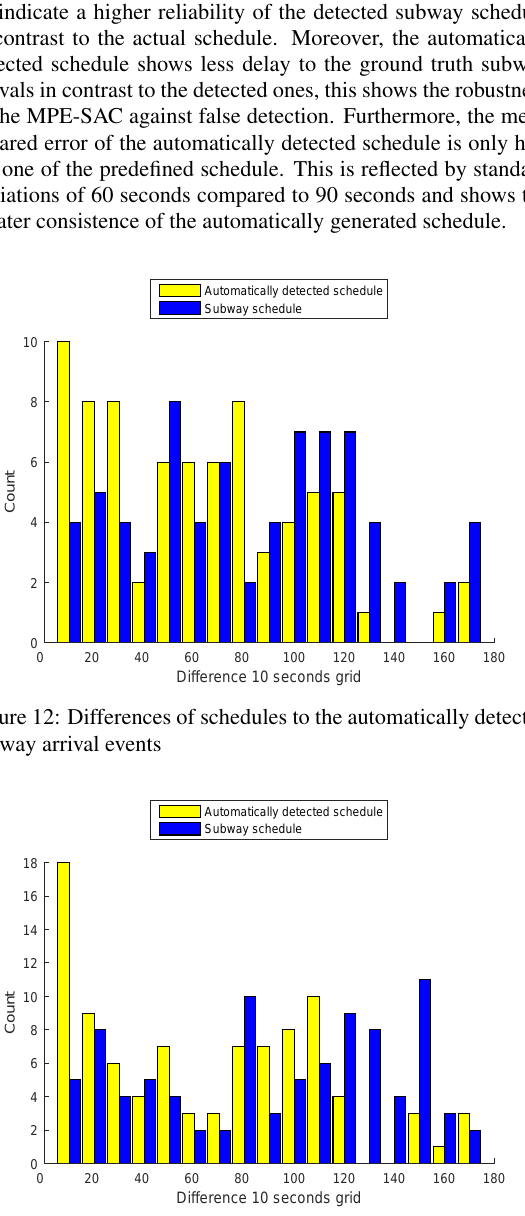
Figure 13: Differences of schedules to the manually detected sub- way arrival